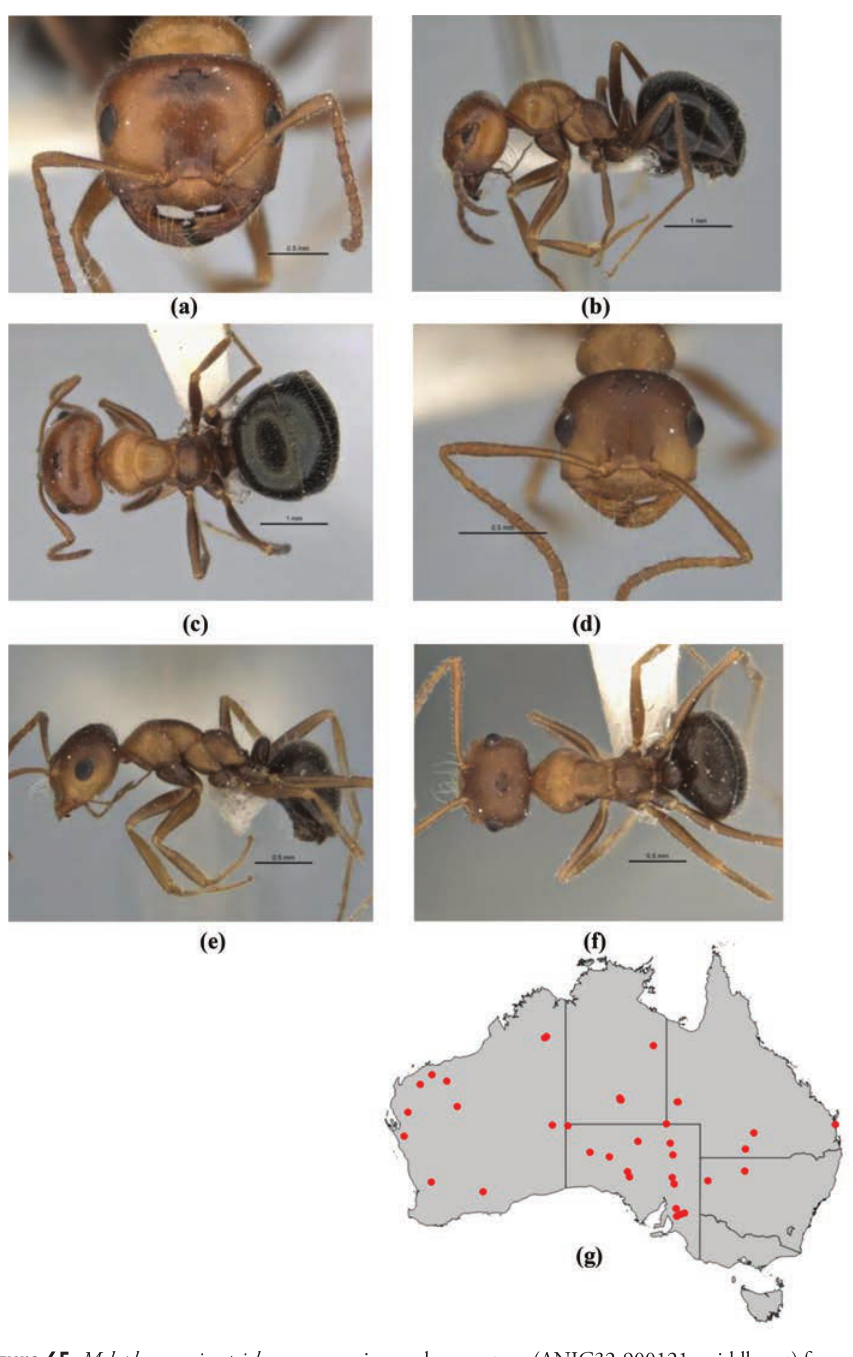
Figure 65. Melophorus microtriches sp. n.: major worker paratype (ANIC32-900121–middle ant) frons ( a ), profile ( b ) and dorsum ( c ); minor worker holotype (ANIC32-900121–bottom ant) frons ( d ), profile ( e ) and dorsum ( f ); distribution map for the species ( g ). Low resolution scale bars: 1 mm ( b, c ); 0.5 mm ( a, d–f